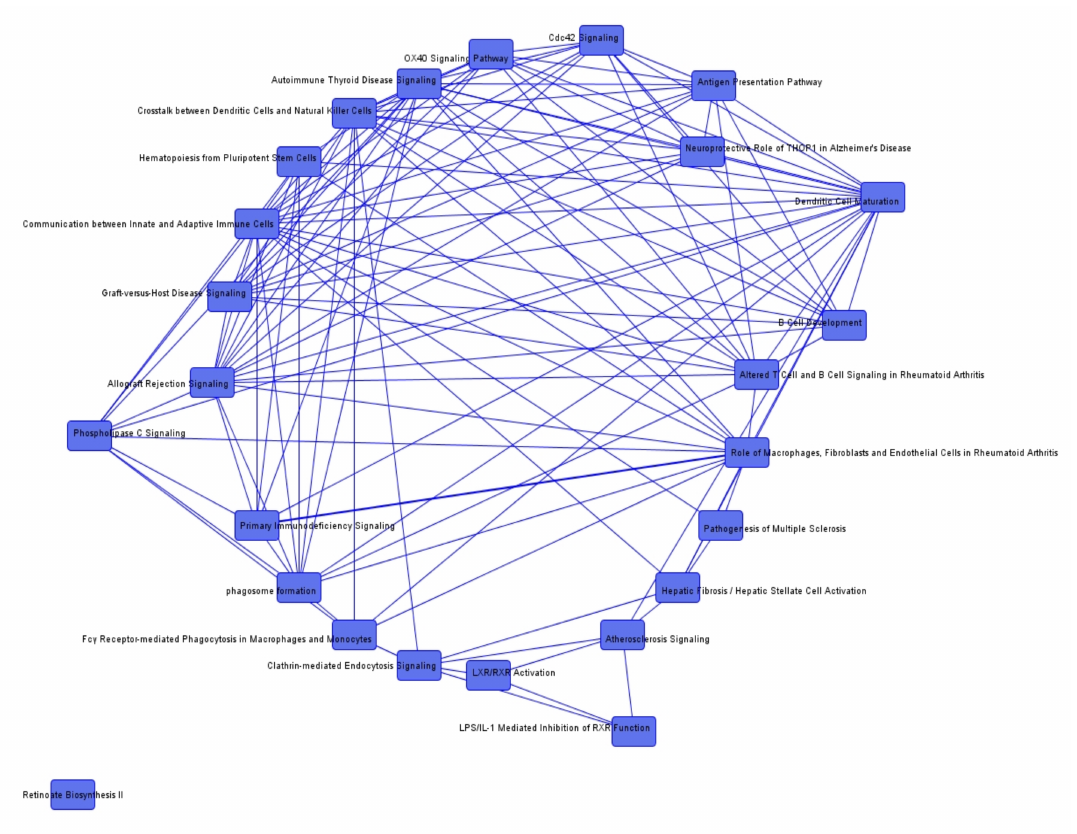
Figure 3. Overlapping canonical pathways in non-irradiated sporadic vs. neurofibromatosis type 2 (NF2) associated vestibular schwannomas